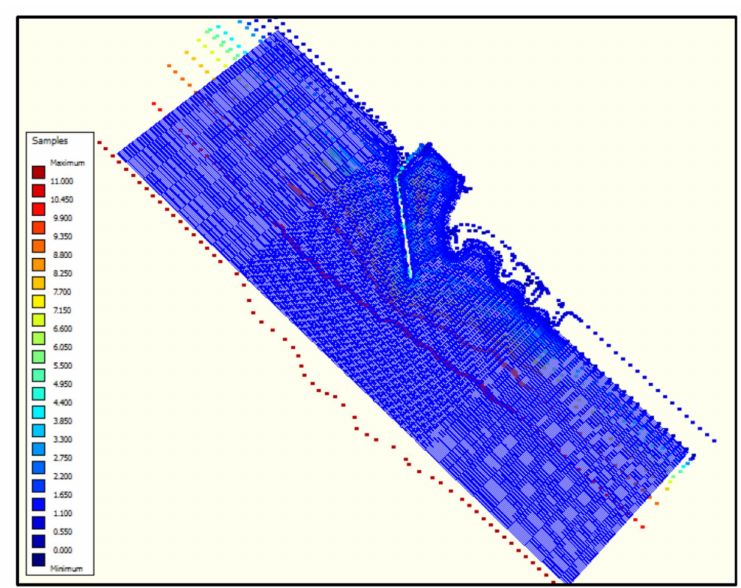
Figure 8. Curvilinear grids and mesh for Nagan Raya port.